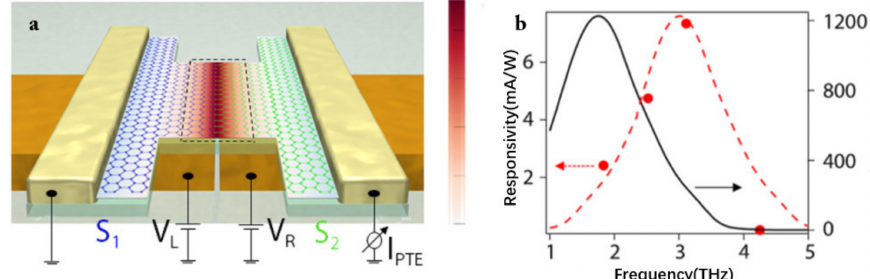
Figure 6. ( a ) The schematic illustration of the fabricated device. Appropriate voltage is applied to both sides of the antenna, and the terahertz radiation will be concentrated in the central part of the graphene channel (where incident terahertz wave is concentrated by the antenna). ( b ) The black line is the simulation result, and the red line is the trend of the experimental results. Reprinted with permission from ref. [72]. Copyright 2019 American Chemical